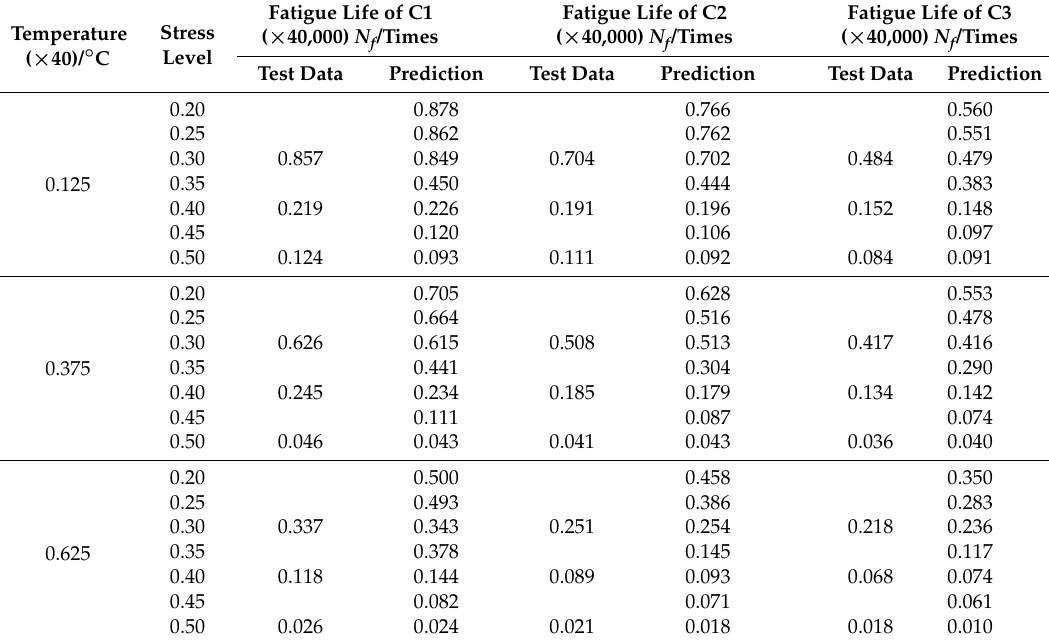
Table 11. Normalized experimental results and prediction results of the